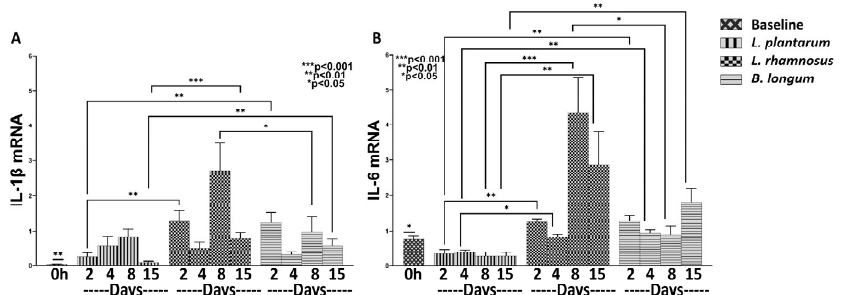
Figure 4. The effects of L. plantarum , L. rhamnosus and B. longum on the pro-inflammatory response. The mRNA expression of IL-1 β ( A ) and IL-6 ( B ) during the healing process. Results are presented as means with SEM. IL-1 β Baseline: ** p < 0.01 compared to L. plantarum (Days 2–8), L. rhamnosus